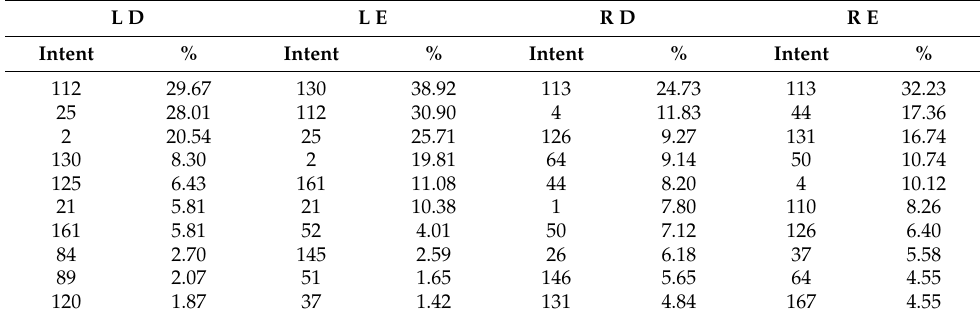
Table 5. Percentage of disinformation and extreme opinion Tweets falling in each class of intent, described in Section 3; R stands for rightist, N for neutral, L for leftist, D for disinformation, and E for extreme